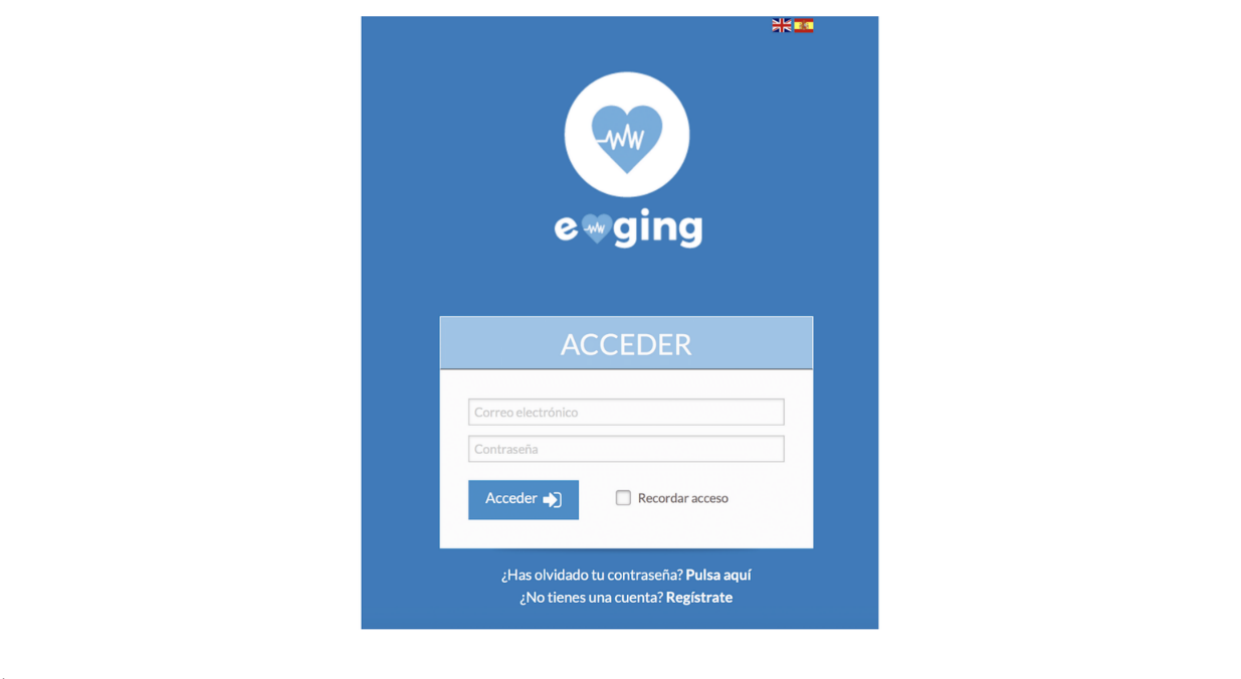
Figure 1. Interface of the app.